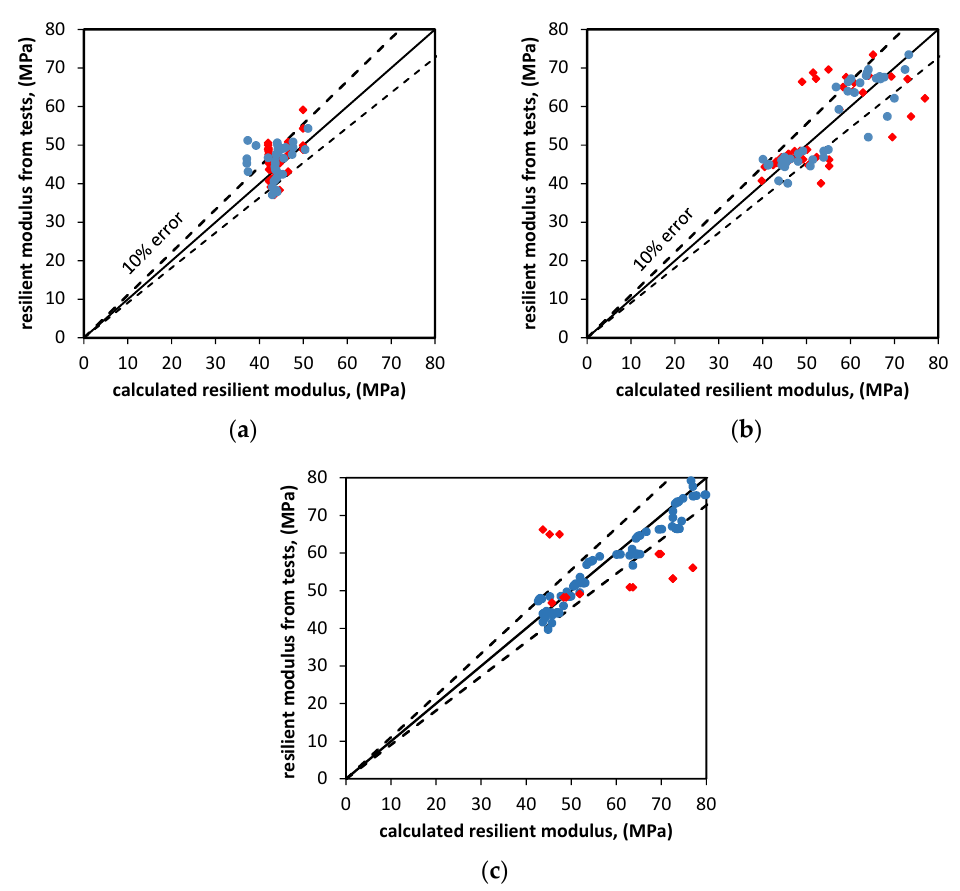
Figure 11. Resilient modulus calculated by the proposed analytical model (blue points) and by the Uzan ‐ Witczak model (red points) versus the resilient modulus value from tests ( a ) σ ’ 3 = 45 kPa; ( b ) σ ’ 3 = 90 kPa; and ( c ) σ ’ 3 = 135 kPa.